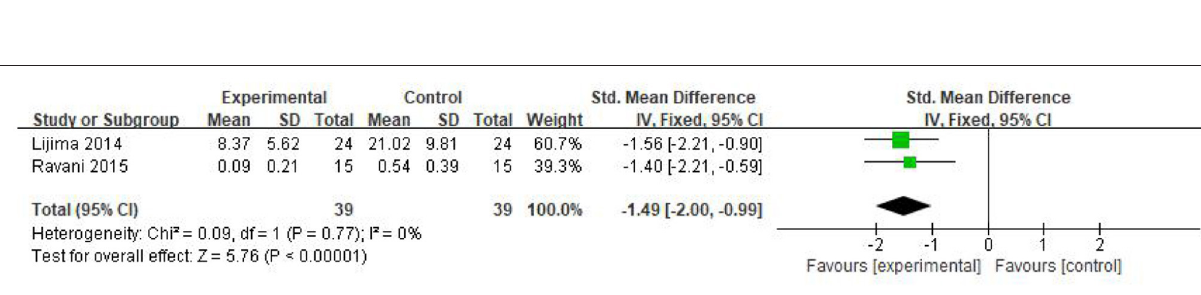
FIGURE 4 | Forest plot showing a meta-analysis for the RTX group vs. control group on the number of patients using steroids or/and CNI.